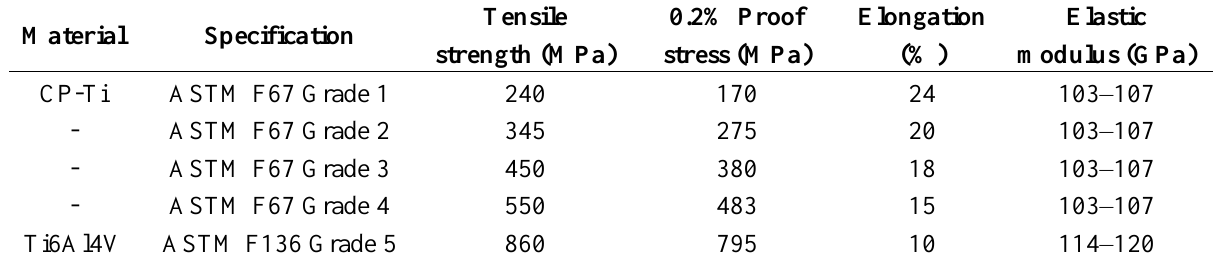
Table 1. Selected mechanical requirements properties of titanium bar for implant